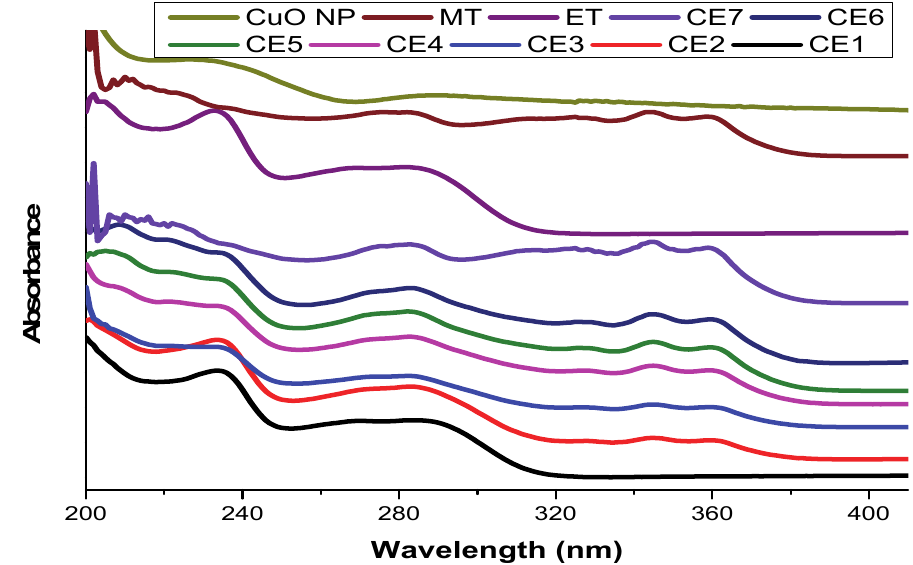
Figure 1. UV/vis spectrum of copper oxide nanoparticles (CuO NPs), etoricoxib (ET), montelukast (MT), and synthesized nanomaterials.